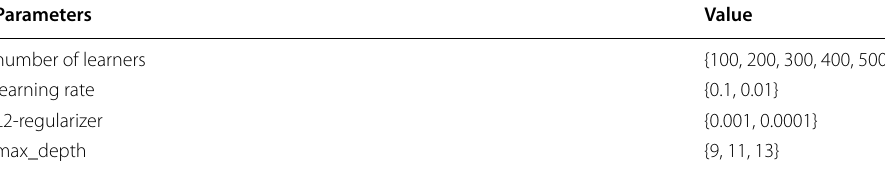
Table 6 Parameter space of